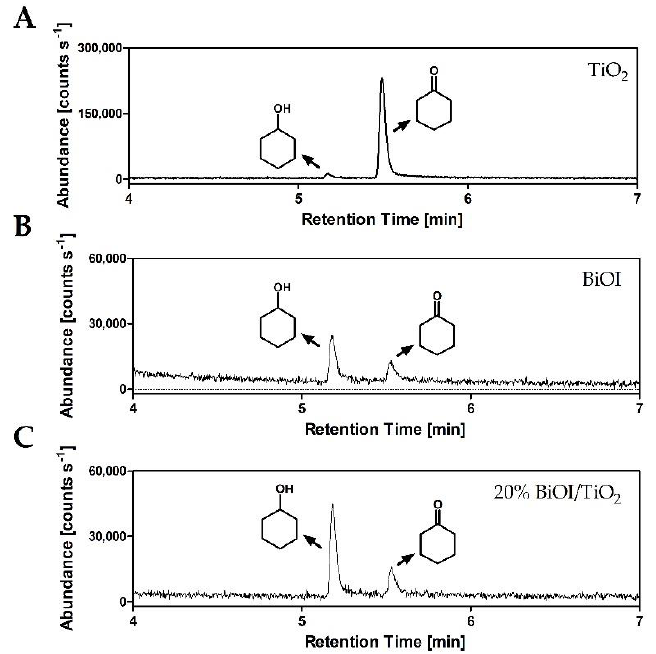
Figure 6. CG chromatogram of oxofunctionalizated products of cyclohexane. ( A ) Titanium dioxide; ( B ) bismuth oxyiodide; ( C ) 20% BiOI/TiO 2 . Oxofunctionalizated products were identified by mass spectrometry. Peak 1 (RT = 5.2 min) corresponds to cyclohexanol and peak 2 (RT = 5.5 min) corresponds to cyclohexanone.